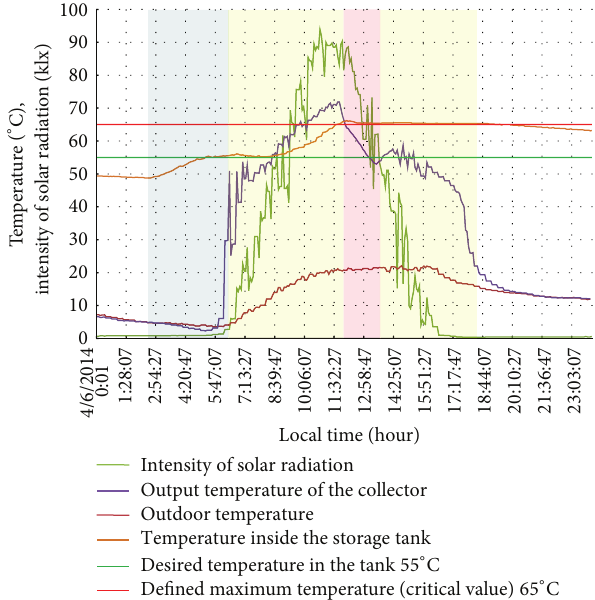
Figure 25: The courses of the monitored values in the experiment on the stagnation